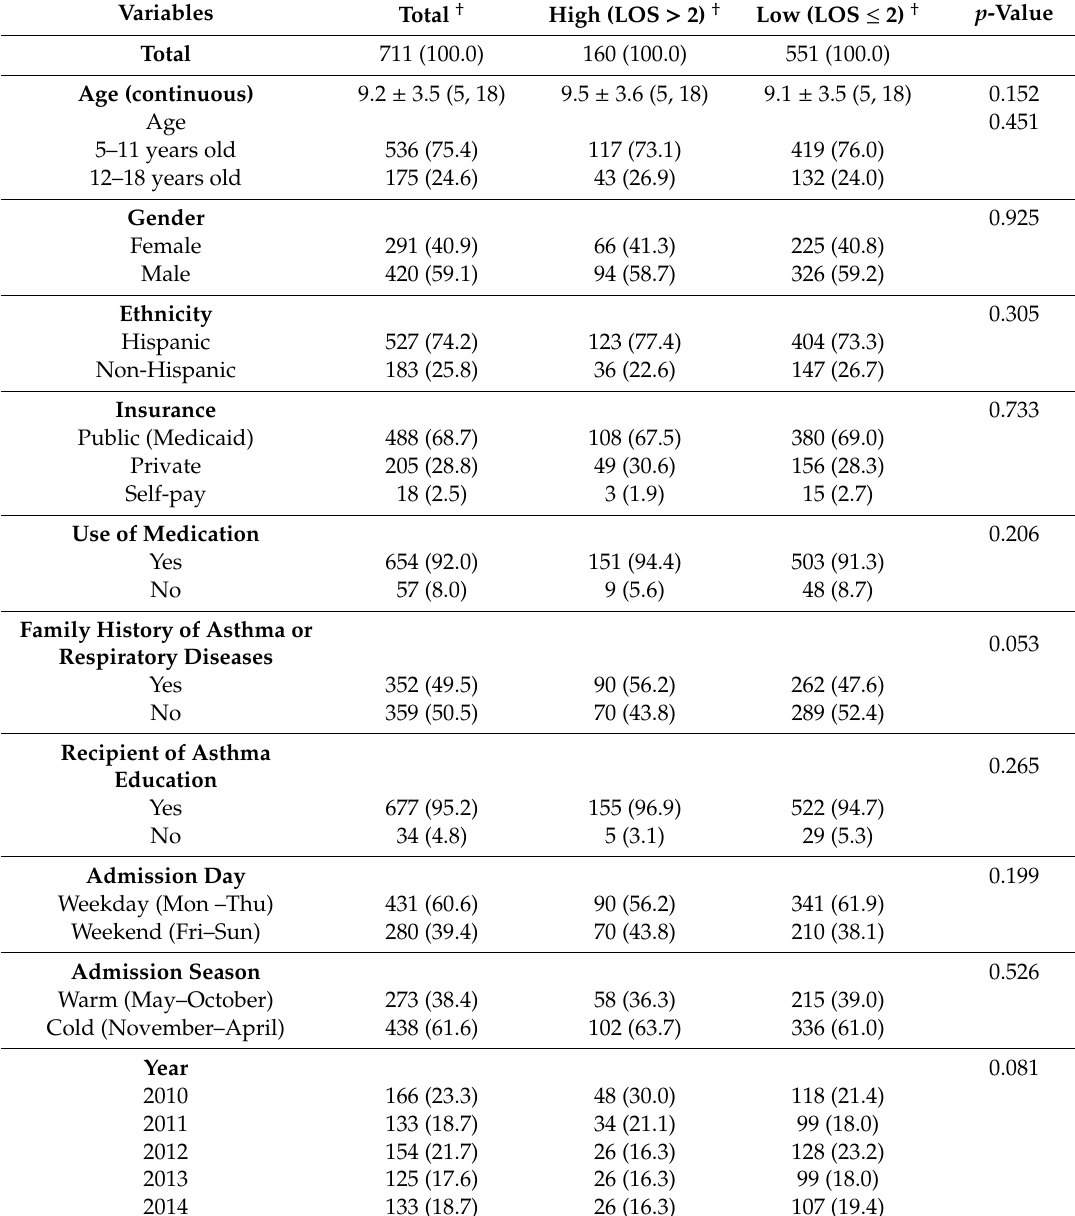
Table 1. Descriptive statistics of study population ( N =